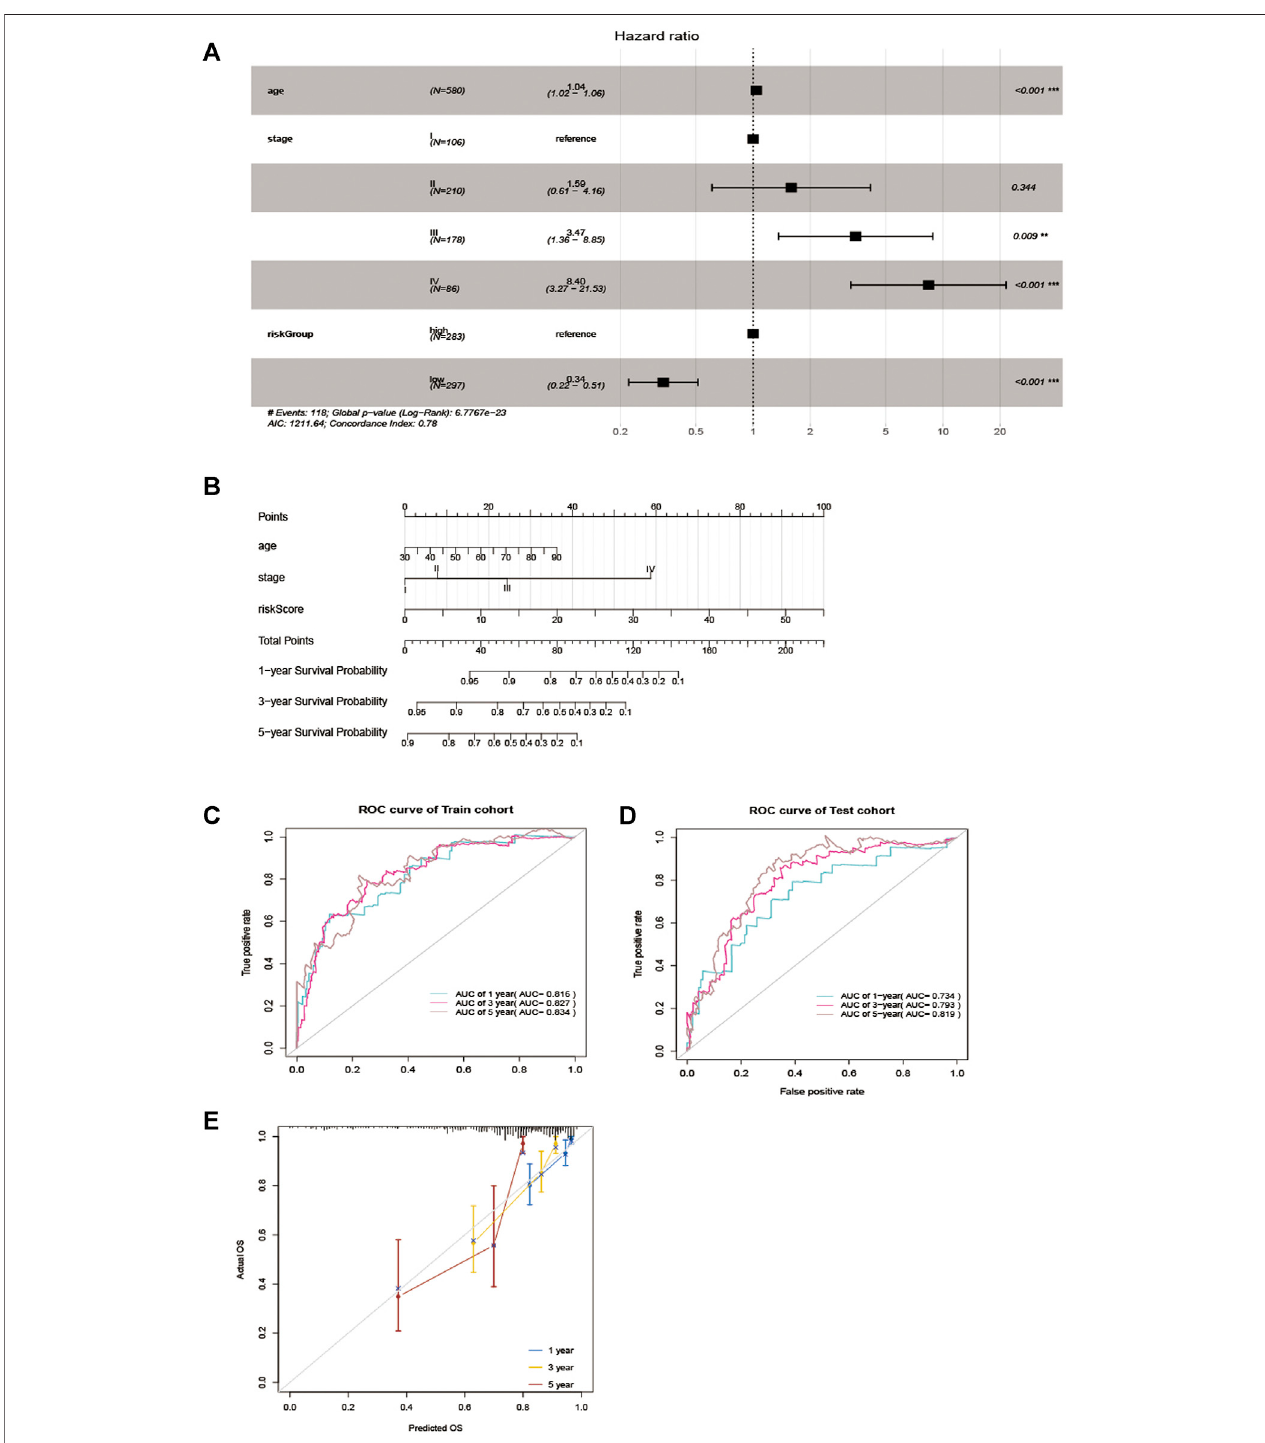
FIGURE 4 | Nomogram for predicting overall survival (OS) of patients with CRC. (A) Multivariable analyses for each clinical feature. (B) Nomogram construction for the 1-, three- and 5 year OS prediction for the CRC. (C, D) Evaluation of the accuracy of the nomogram in 1-, three- and 5 years by using the ROC analysis. (E) Calibration curve for the nomogram model for predicting 1-, three- and 5 years OS.